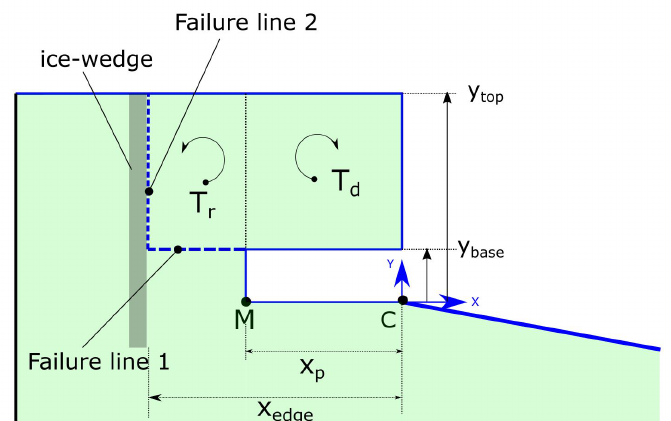
Figure 6. Stability of an overhanging bluff over a niche. Two failure lines are marked 1 (horizontal) and 2 (vertical). The forces acting along the horizontal failure line creates moment T b